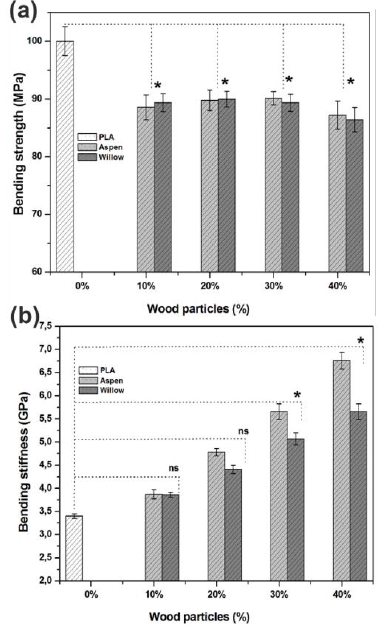
Figure 4. Comparison of the bending properties between the PLA and biocomposite samples: ( a ) Bending strength and ( b ) Bending sti ff ness. (* significant di ff erence at p < 0.05 and ns not